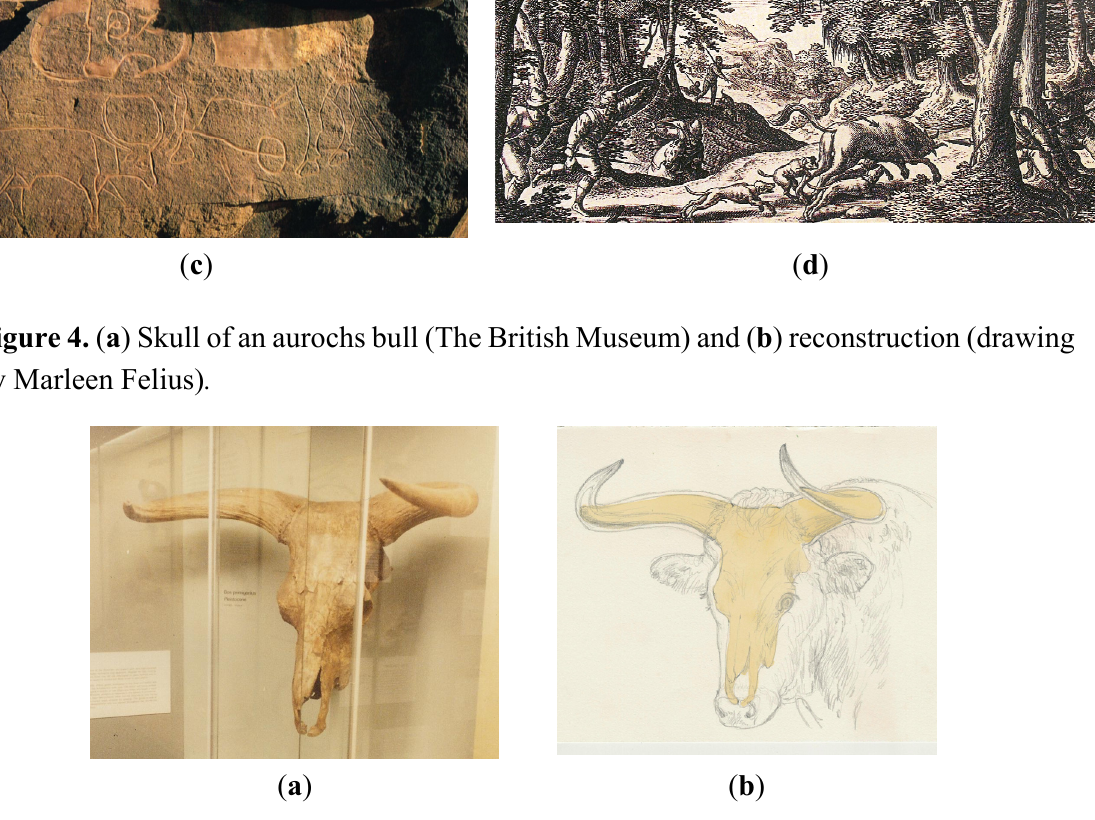
Figure 5. Archaeological sites that witness the domestication of taurine cattle (Middle Euphrates [18,25]) and zebu (Mehrgarh, [26]), their early dispersal (Catal Hüyük [27]) and the arrival of taurine cattle in Greece (Argissa-Magula, Nea Nikomedeia [2]) and Egypt (Fayum [28–31]). Domestication in Nabta Playa and Bir Kiseiba in South Egypt is not generally accepted [30,32,33]. In addition to the skeletal remains excavated at these